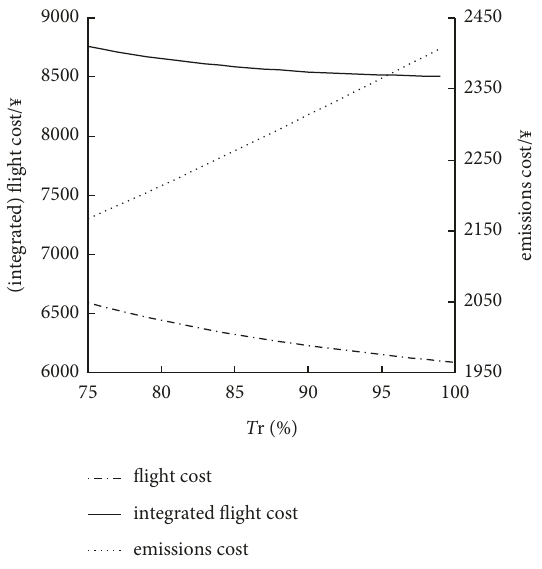
Figure 3: Variation of cost with T